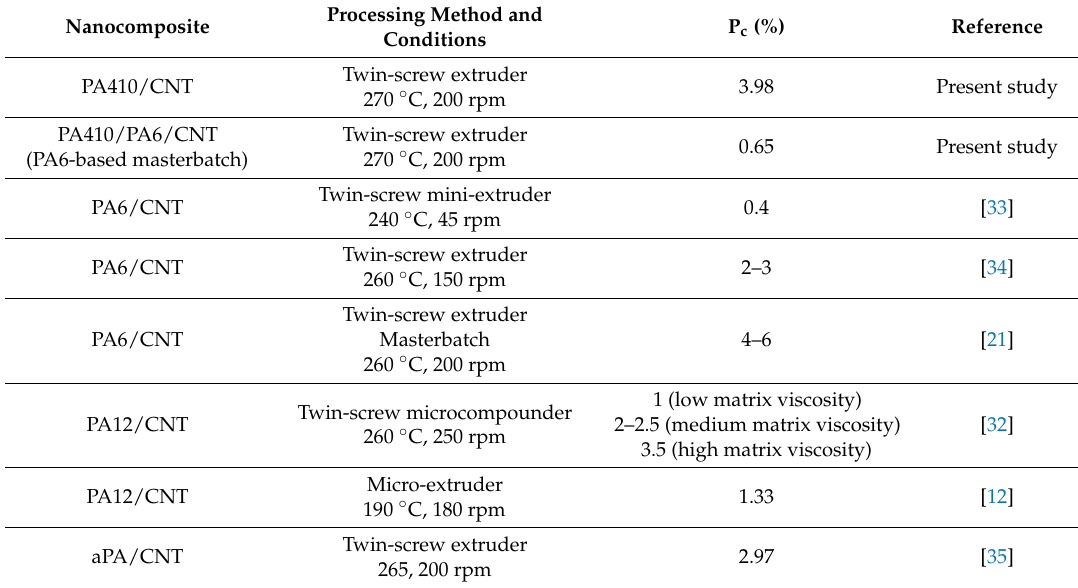
Table 5. Percolation thresholds obtained for melt-processed PA-based systems in the present and other works. Nanocomposite